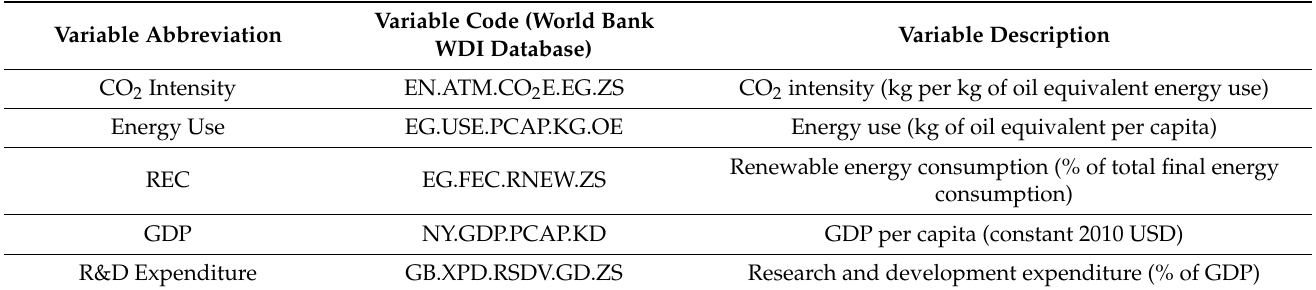
Table 1. Variable